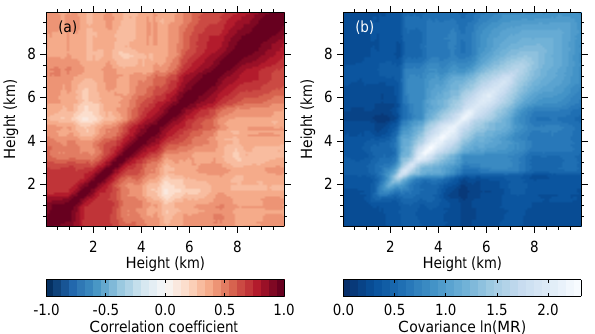
Figure 3. Correlation (a) and covariance matrix (b) derived from 211 radiosondes for HOPE. Both are shown for the natural loga- rithm of the mixing ratio (ln(MR)) as a function of height with a resolution of